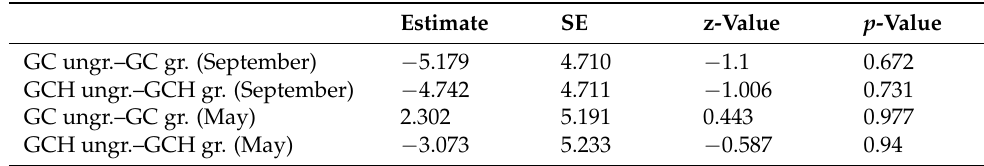
Table A29. Differences in activity densities of herbivore carabid beetles, comparing the grazed pastures and ungrazed strips of the grass–clover (GC) and the grass–clover herbs (GCH) in May/June and September.